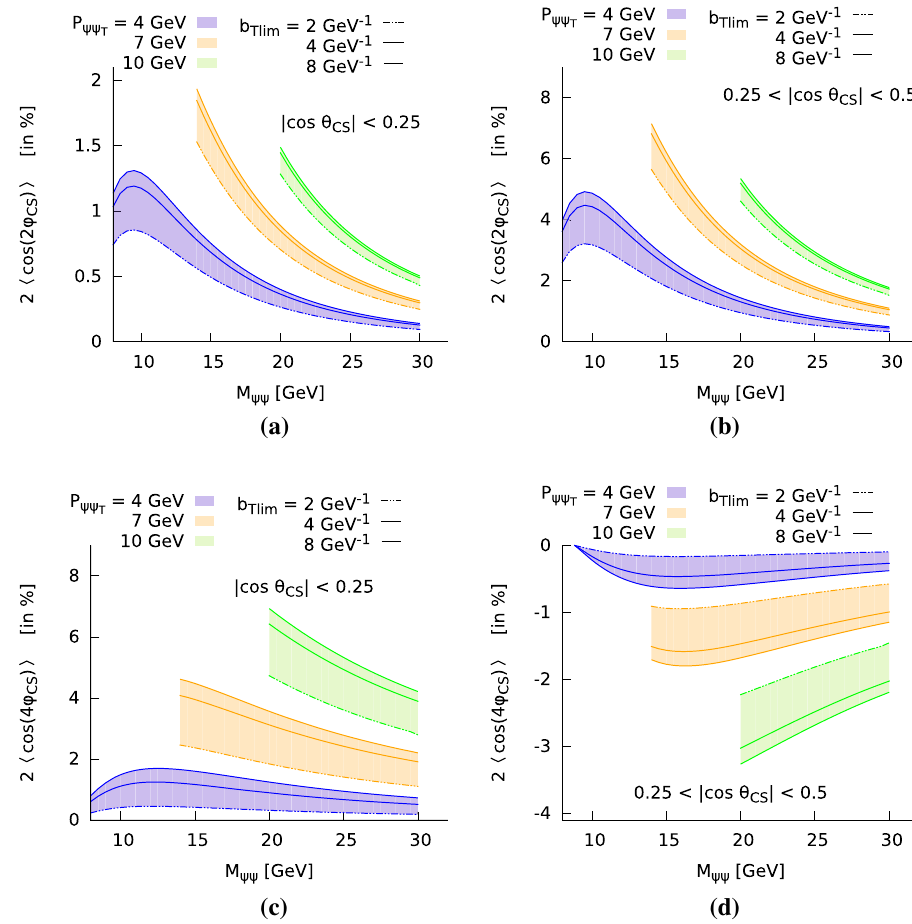
Fig. 5 The azimuthal asymmetries for di- J